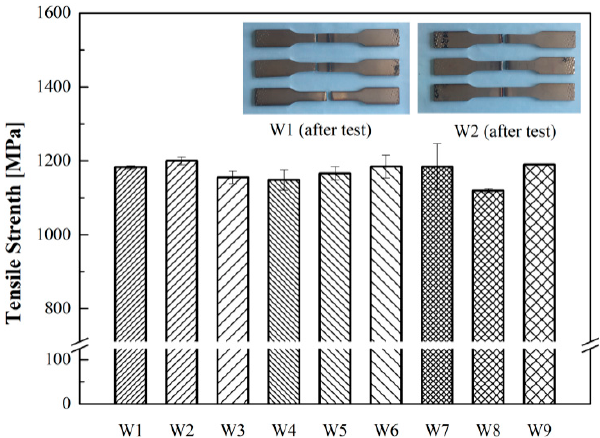
Figure 8. Tensile strength of welded TC31 specimens by wave laser oscillating welding method at room temperature. (The insets show the photographs of W1 and W2 joints after the tensile test.).